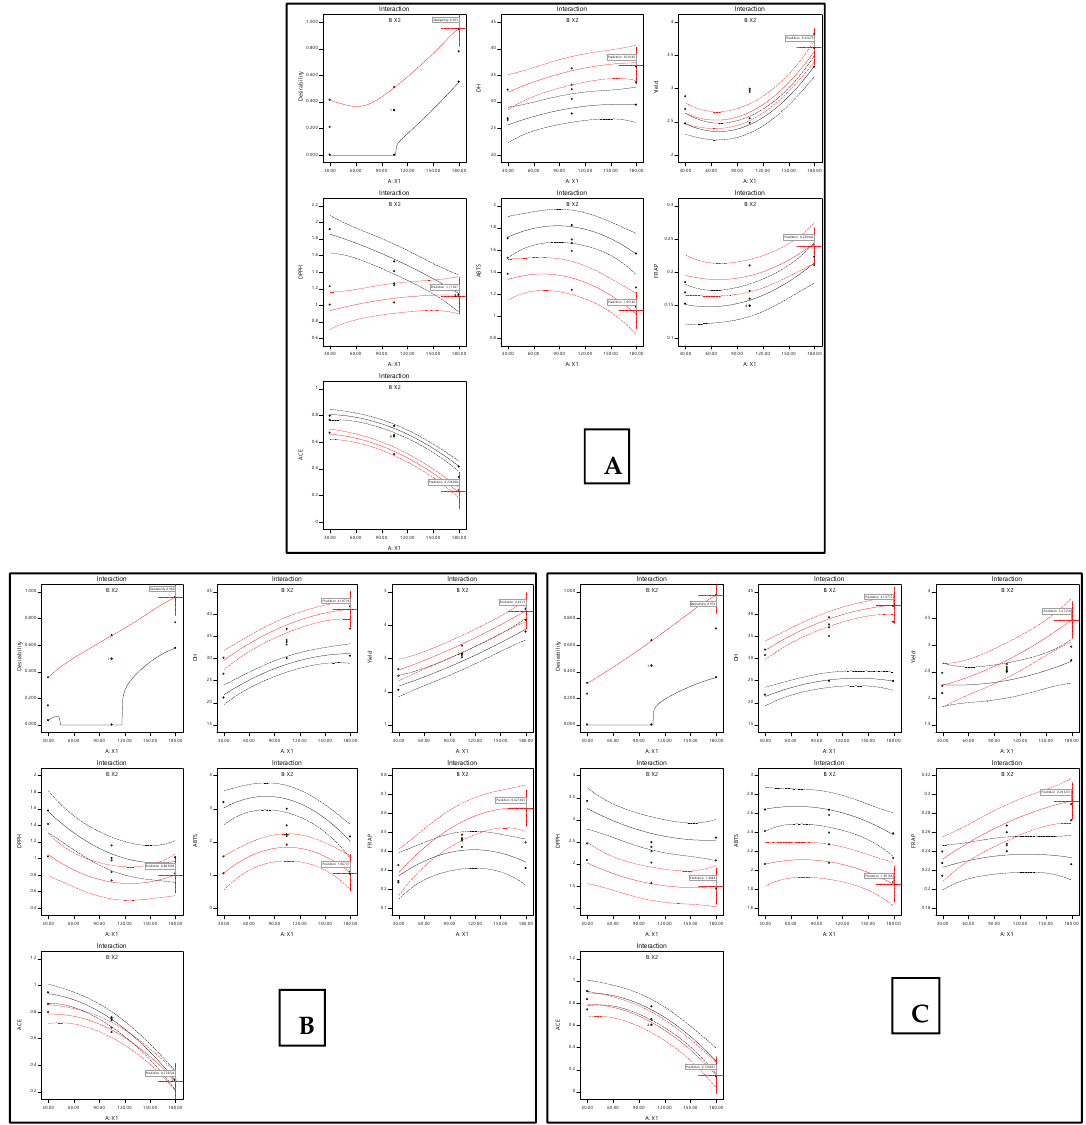
Figure 3. Interaction plot of hydrolysis time (X 1 ) and enzyme concentration (X 2 ) for DH, yield, DPPH radical scavenging activity, ABTS radical scavenging activity, FRAP assay and ACE inhibitory activity of TBH using Alcalase ( A ), Neutrae ( B ) and Flavourzyme ( C ).